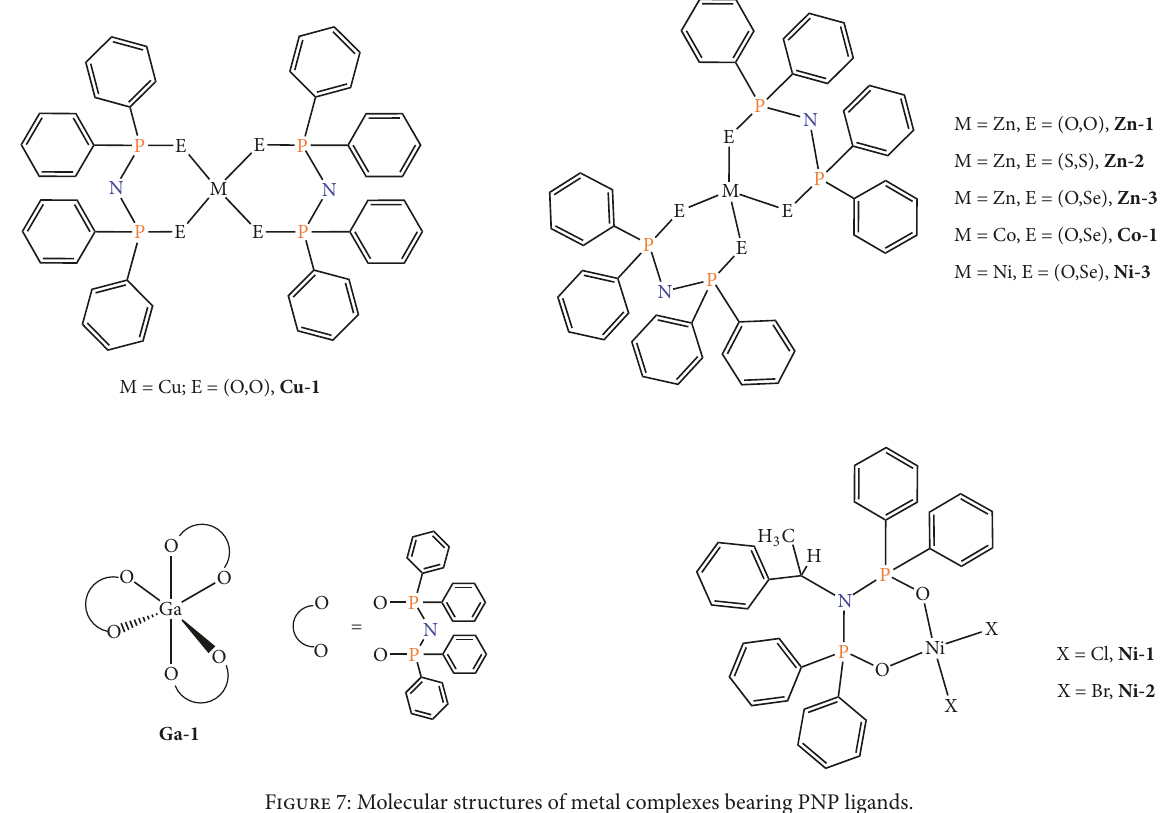
Figure 7: Molecular structures of metal complexes bearing PNP ligands.